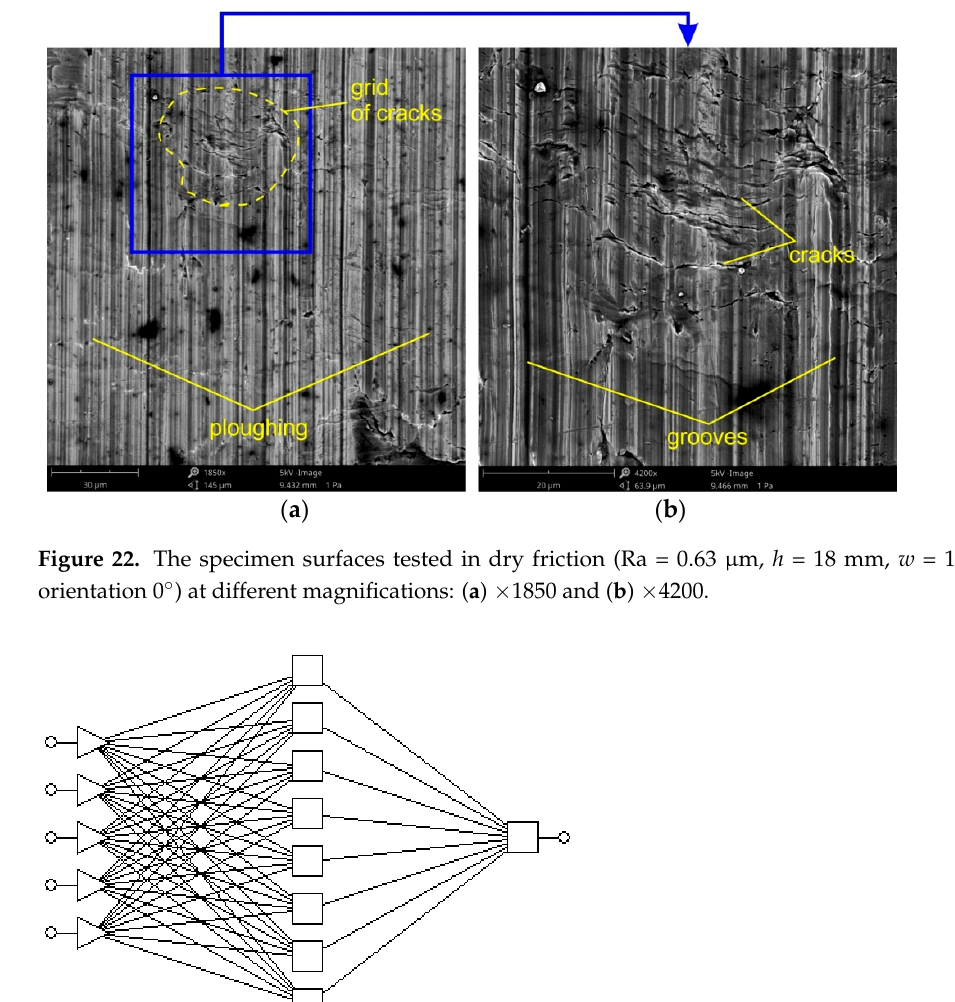
Figure 22. The specimen surfaces tested in dry friction (Ra = 0.63 μ m, h = 18 mm, w = 14 mm, ori- entation 0°) at different magnifications: ( a ) ×1850 and ( b ) ×4200.